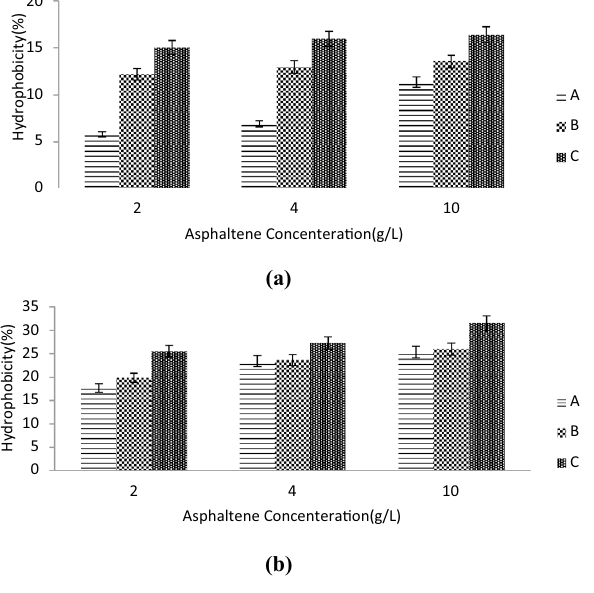
Fig. 9 Effect of types of microorganisms on Ahwaz-Bangestan and Kuh-e-Mond asphaltene biodegradation: a without SDBS presence and b with SDBS